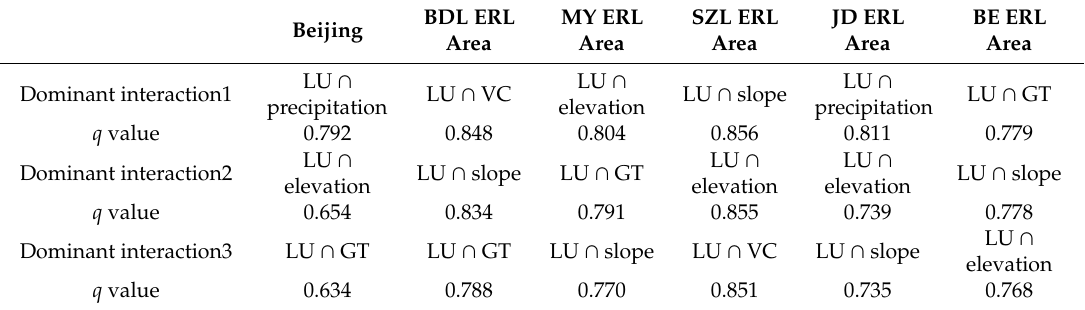
Table 5. The dominant interactions of factors a ff ecting water yield in water retention ERL